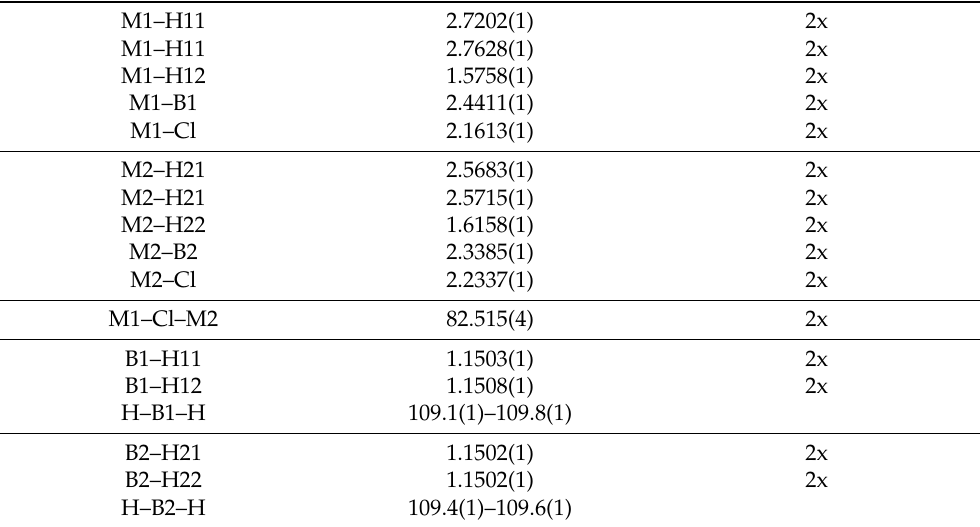
Table 3. Bond distances (Å) and angles ( ◦ ) in the LiAl(BH 4 ) 2 Cl 2 compound. (M1 and M2 atoms consist of Li or Al, partially occupied the 4a positions.). Since only the centers of gravity of two symmetrically independent (BH 4 ) − groups were refined, the M–H bond lengths are